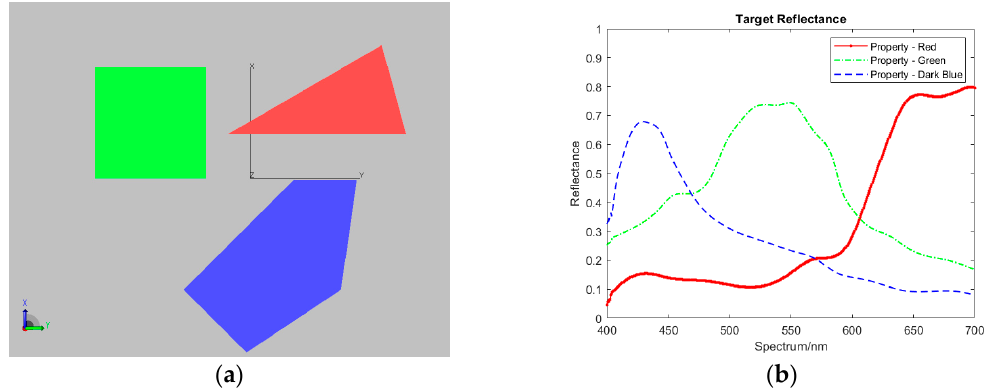
Figure 7. Samples of 3D targets for testing: ( a ) RGB presentation. ( b ) Spectral reflectance characteristics of the three targets.